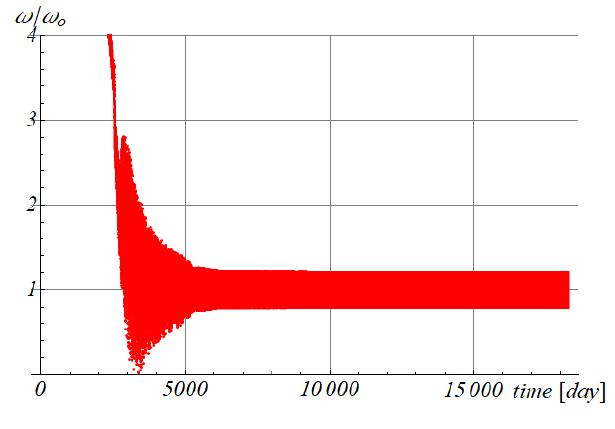
Figure 13. Angular velocity to orbital angular velocity ratio ω / ω 0 in gravity tumbling.